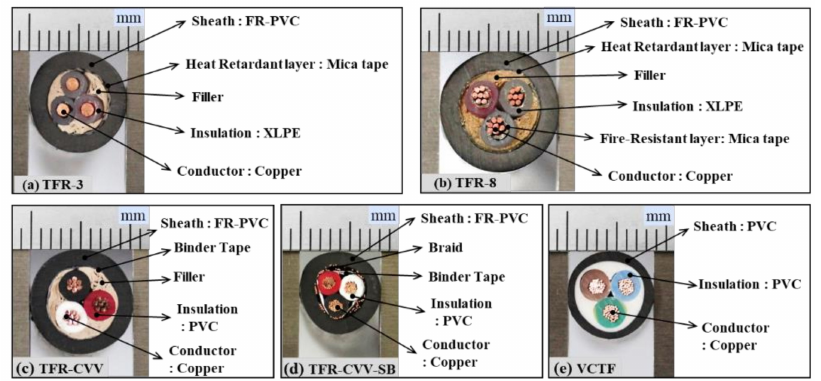
Figure 1. Photographs of cross-section and multiple materials for the cables considered in this